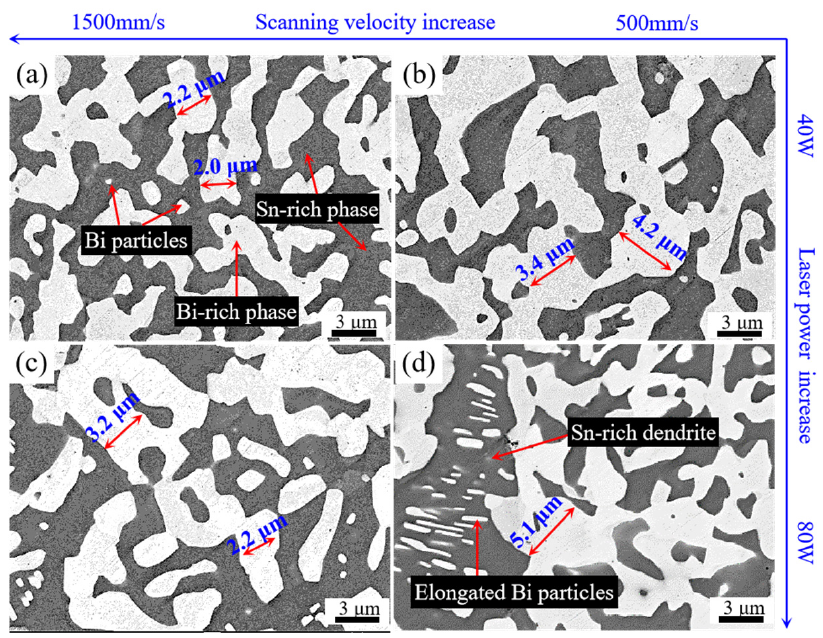
Figure 5. Enlarged BSE images of Sn58Bi alloy specimens: ( a ) 40 W with 1500 mm/s, ( b ) 40 W with 500 mm/s, ( c ) 80 W with 1500 mm/s, ( d ) 80 W with 500 mm/s.